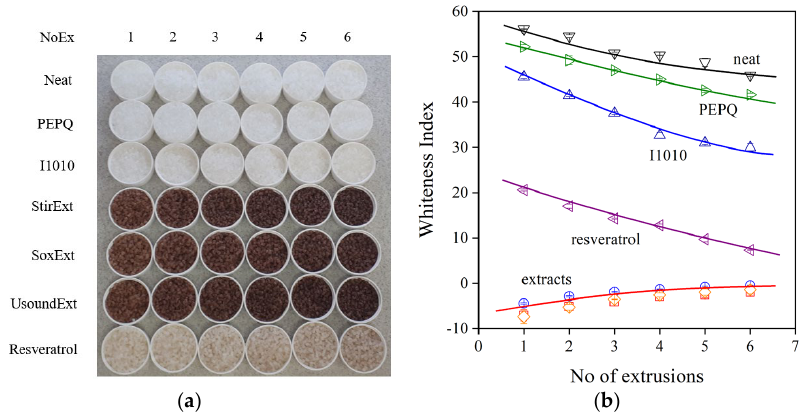
Figure 9. Discoloration of polyethylene containing various additive packages during processing. ( a ) A visual view of the samples and ( b ) whiteness index plotted against the number of extrusions. Symbols are the same as in Figure 6.